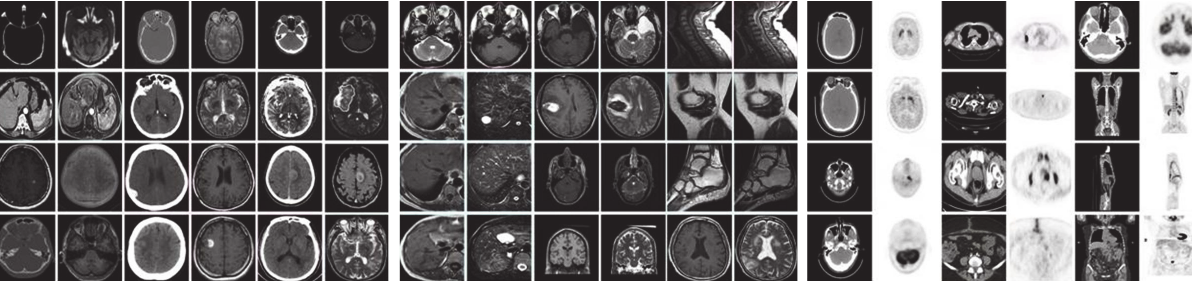
Figure 3: The source images for fusion and training dictionary, including 12 pairs of CT/MR images, 12 pairs of MR-T1/MR-T2 images, and 12 pairs of CT/PET images.